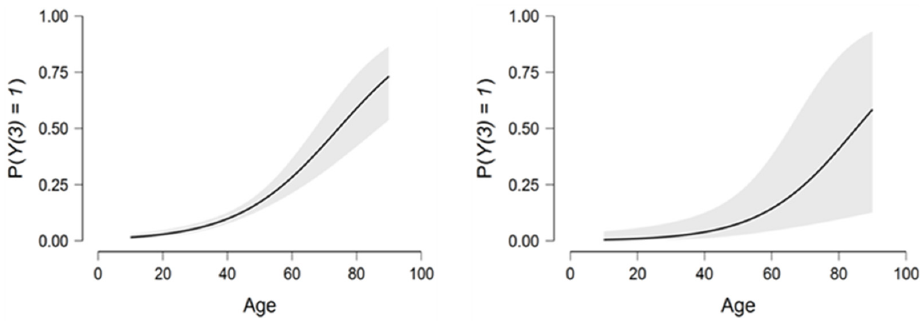
Figure 5. Relationship between the dependent variable Y 3 and the age variable.